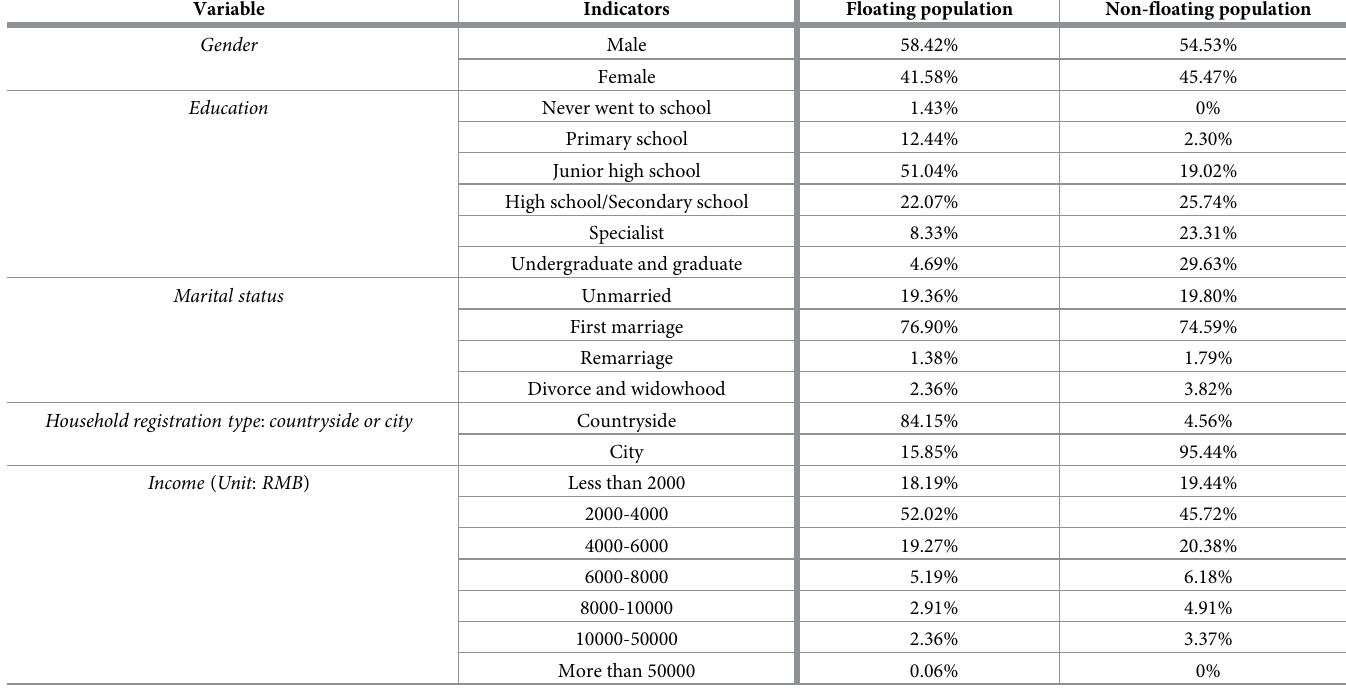
Table 1. The basic characteristics of the